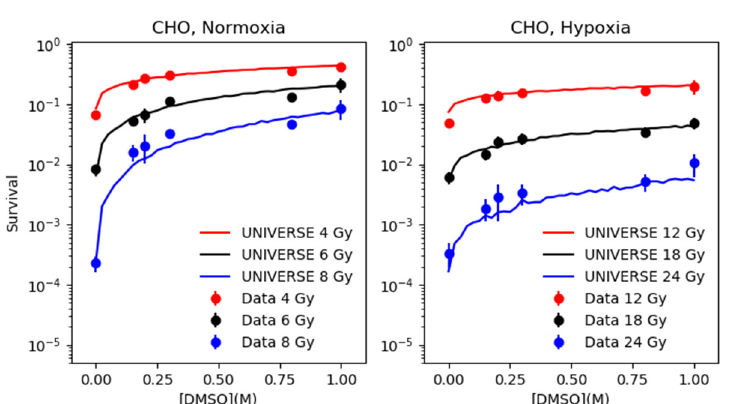
Figure 3. CHO cell survival data (dots with error bars) in normoxia (left panel) and in hypoxia (right panel) as a function of DMSO concentration in units of M for di ff erent dose levels as shown in the legends, taken from Hirayama et al. [12], are compared against model predictions (lines).